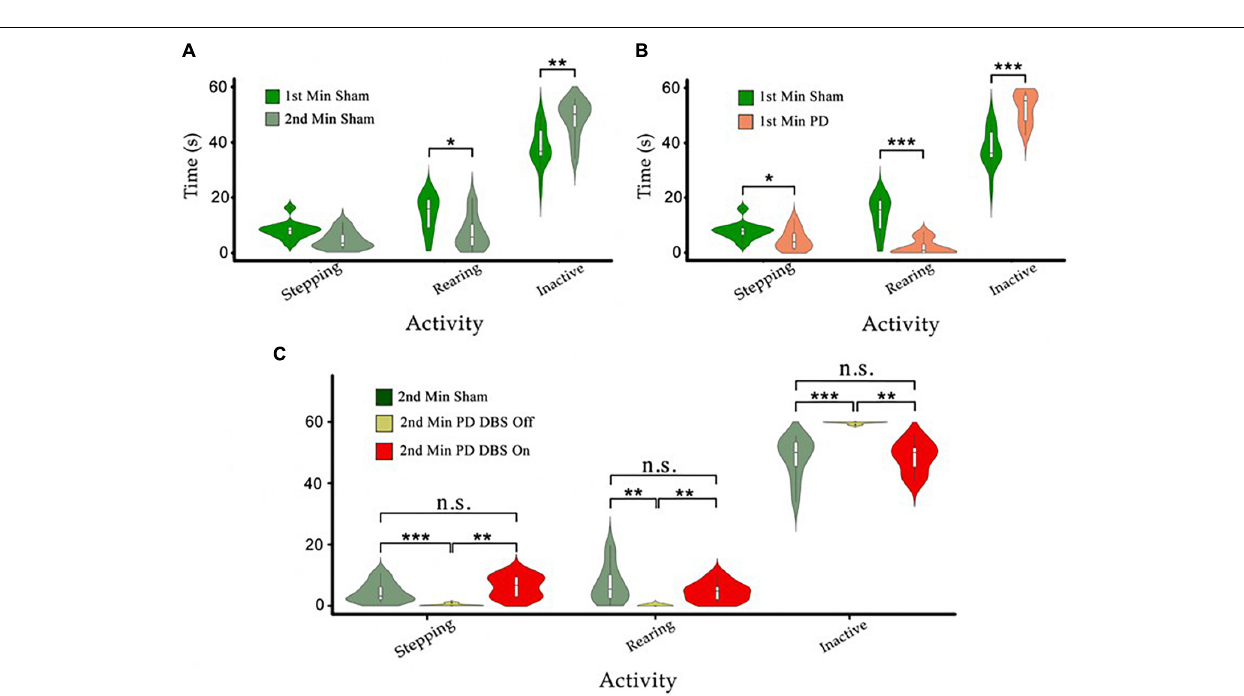
FIGURE 6 | (A) The time sham animals spend in stepping, rearing, and inactivity during the first minute of the tests was compared to the second minute. We observe decreases in stepping and rearing behavior and an increase in the time spent in the inactive state. (B) Comparison in the same behaviors as in (A) between PD and sham rats during the first minute. (C) The behavioral patterns of PD-DBS ON, PD-DBS OFF, and sham animals during the second minute of the cylinder test. We see a similar pattern for PD-DBS ON and sham rats and a drastically impaired pattern in PD-DBS OFF rats, which spend nearly all of their time in the inactive state. Level of significance (* p < 0.05, ** p < 0.01, *** p < 0.001, and n.s. stands for not significant). Figure adapted from Mottaghi